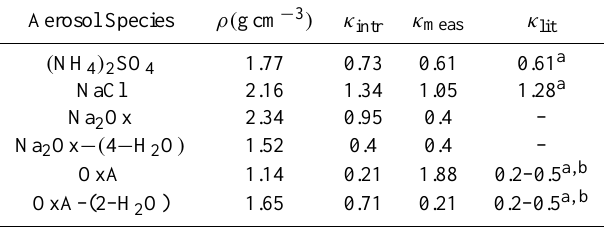
Table 2. κ values for mono-valent salts. κ intr calculated us- ing Eq. (5). The densities are from CRC handbook, except for Na 2 Ox − ( 4 − H 2 O ) , which was assigned a density of 1.52gcm − 3 . Aerosol